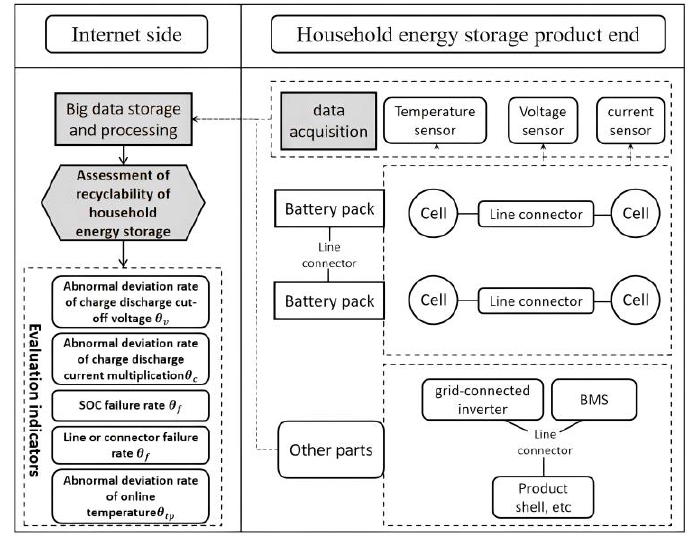
Figure 3. Feasibility assessment process of household energy storage and recovery.